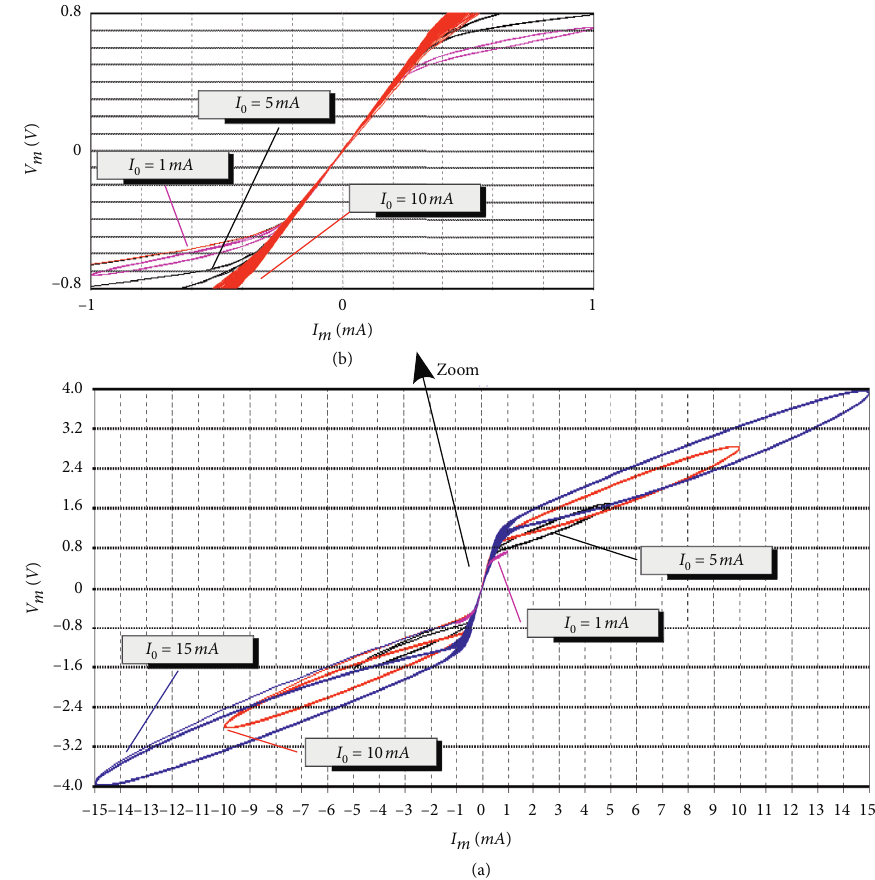
Figure 2: Current-voltage characteristics obtained through the LTspice simulations of the memristor emulator driven by a current source i � I ( 2 π ft ) at a constant frequency f � 300Hz with different I m o sin � 15mA. (b) An amplified view of the zero-crossing V − i omitting the lobe at I I o